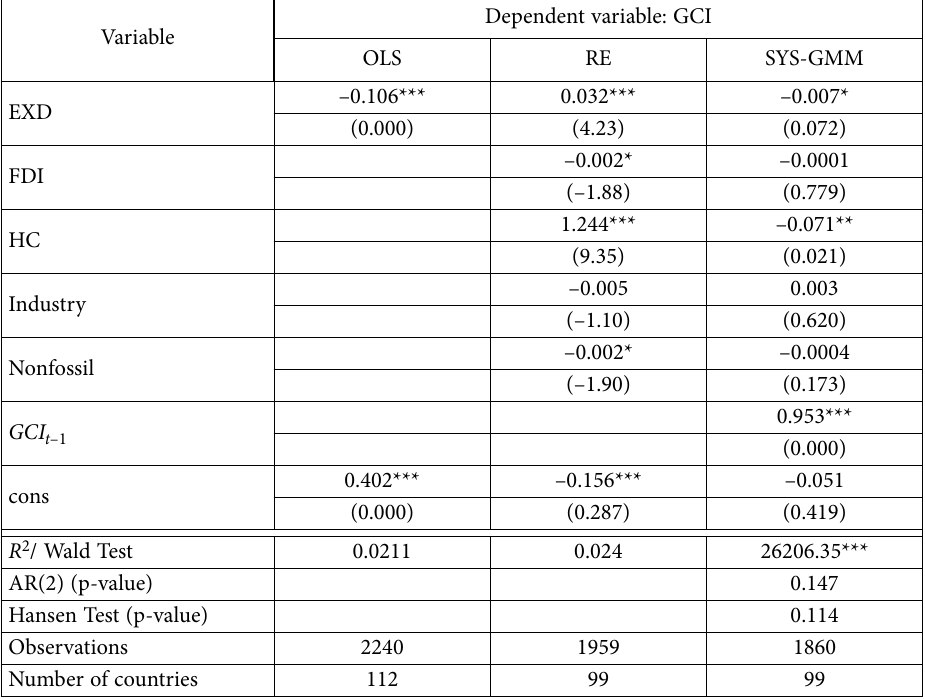
Table 4. Estimation results of the basic